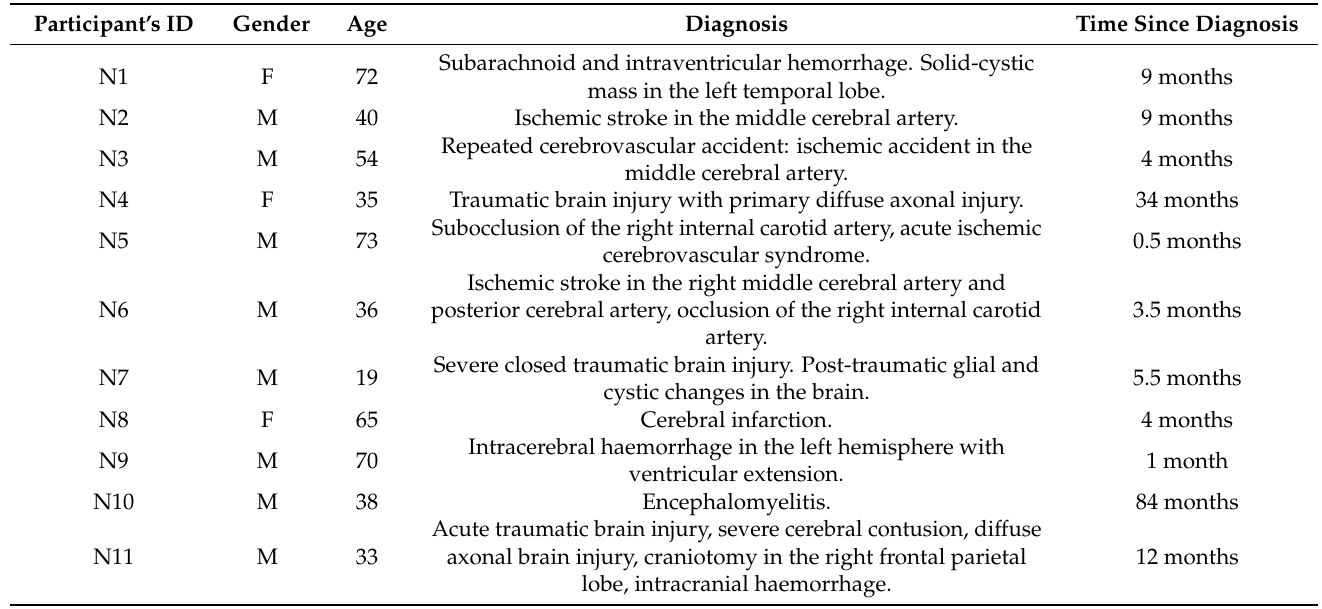
Table 1. Participants’